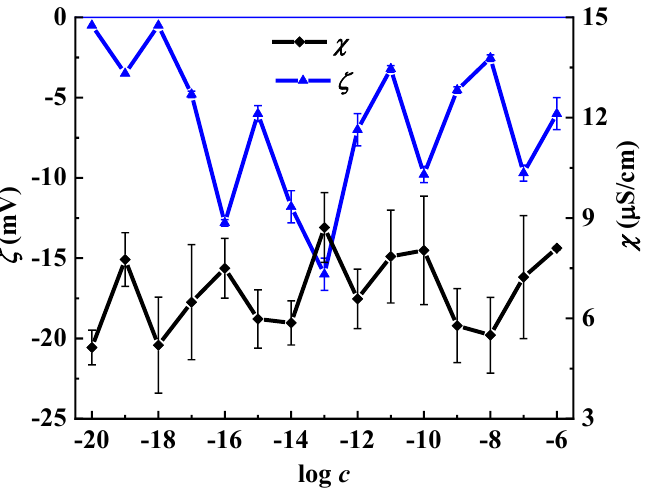
Figure 3. Dependence of the specific conductivity ( χ ) and ζ -potential ( ζ ) on the concentration (c, mol/L) of the L -Trp systems, 25 °C.